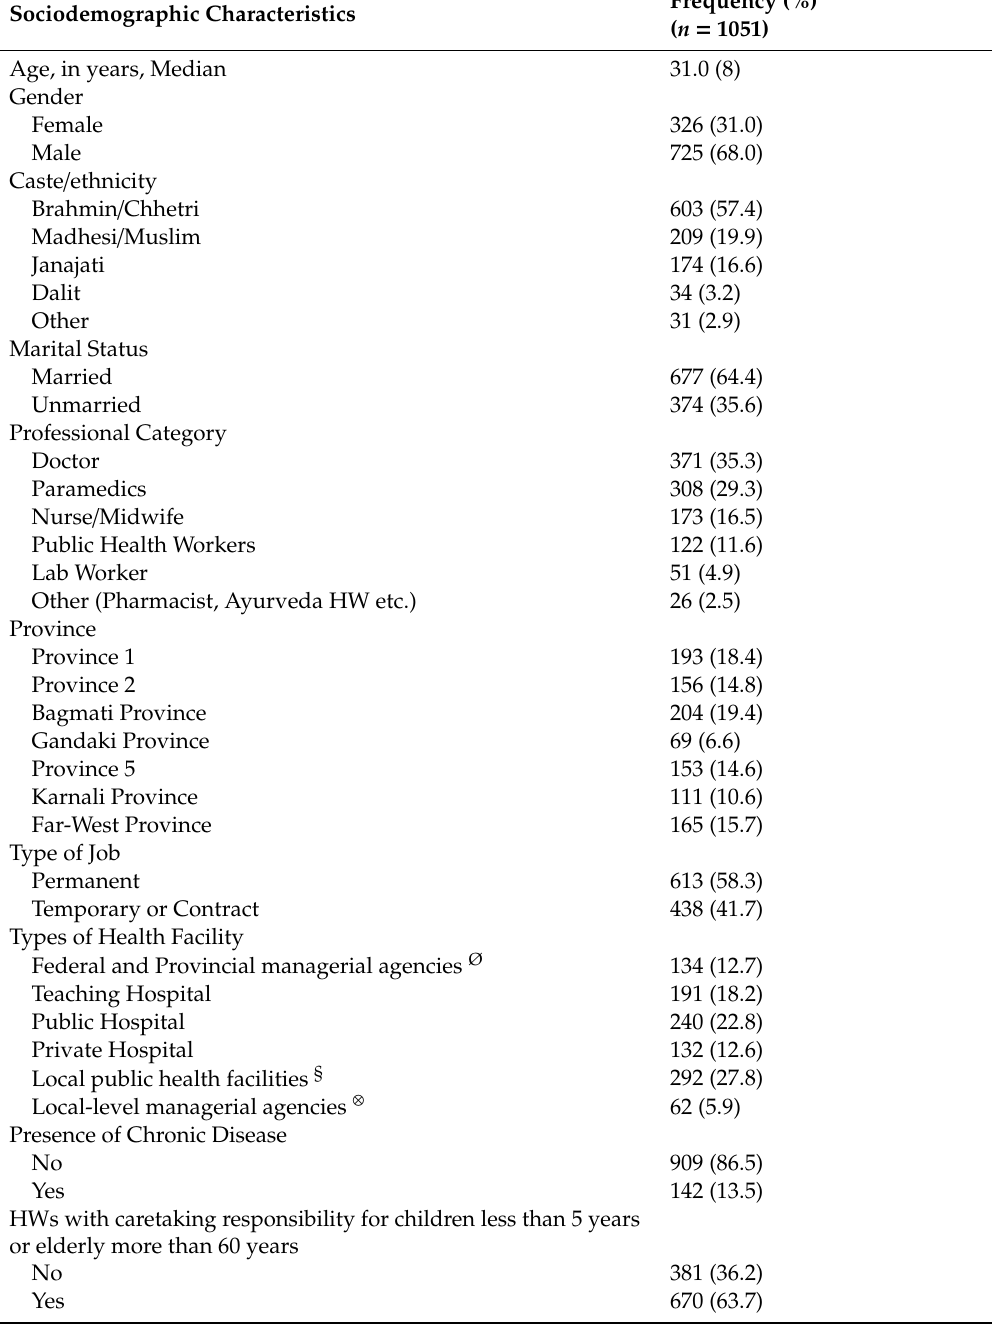
Table 1. Sociodemographic characteristics of health workers in